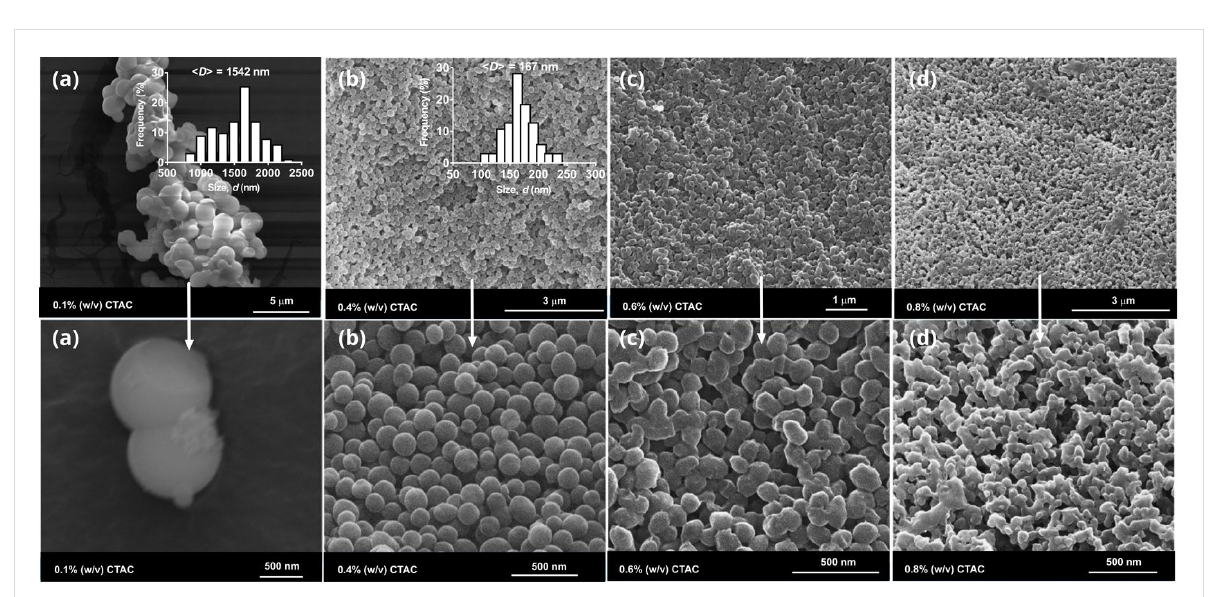
Figure 8: SEM images of the nanoparticles produced at various CTAC concentrations: (a) MSN-16 ( r (CD/CTAC) = 10), (b) MSN-17 ( r (CD/CTAC) = 2.5), (c) MSN-18 ( r (CD/CTAC) = 1.66) and (d) MSN-19 ( r (CD/CTAC) = 1.25); c β -CD = 1% (w/v). The size distribution plots of the respective particles were shown as